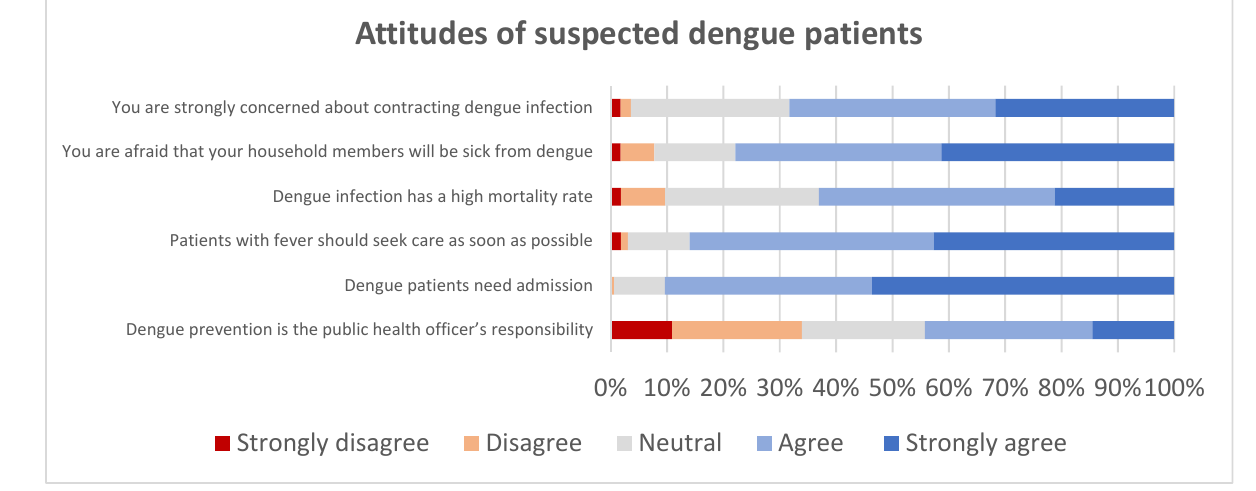
Figure 1. Attitudes of suspected dengue patients.